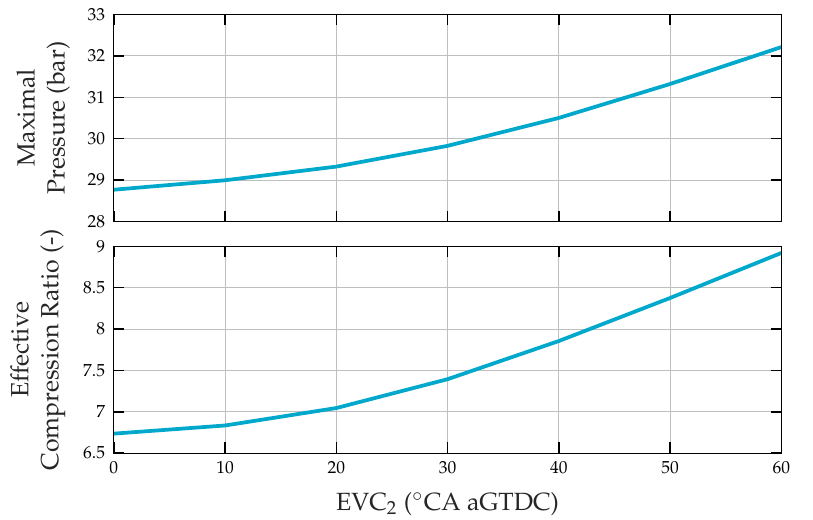
Figure 4. Simulated progression of maximal in-cylinder pressure during combustion and effective compression ratio depending on EVC 2